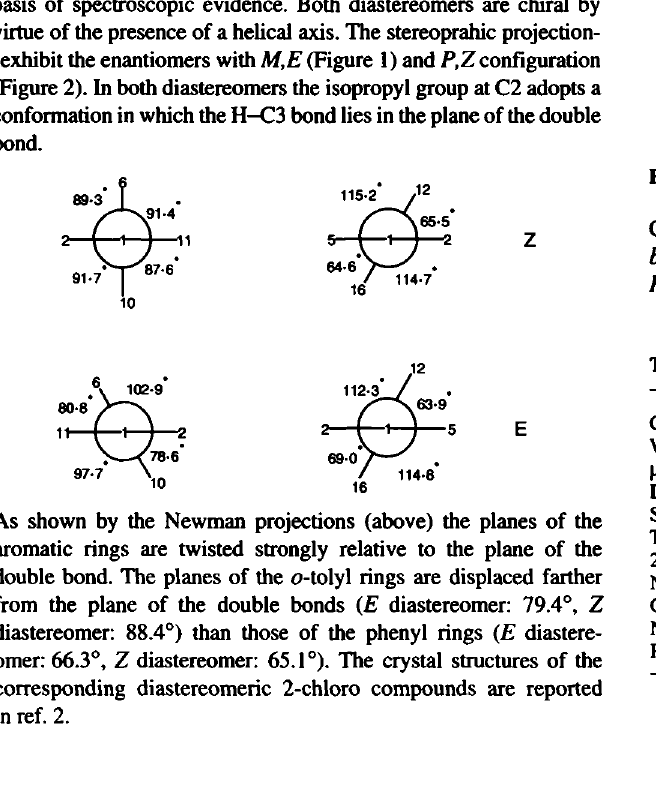
Pig. 1. Molecule plot of the P, Ζ diastereomer of С4Н4(СбН5)(С7Н7)ВгСНз. Ci8Hi9Br, orthorhombic, Pcali (No. 29), a =27.643(6) Â,